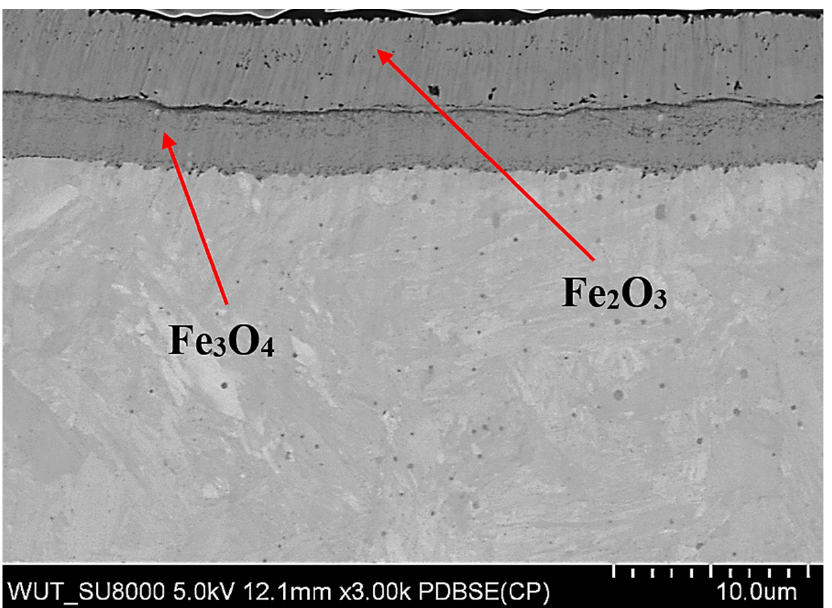
Figure 5. Structure of the v2 sample with the oxide layer (total annealing time 22 h, SEM) magnifi- cation 3000×.